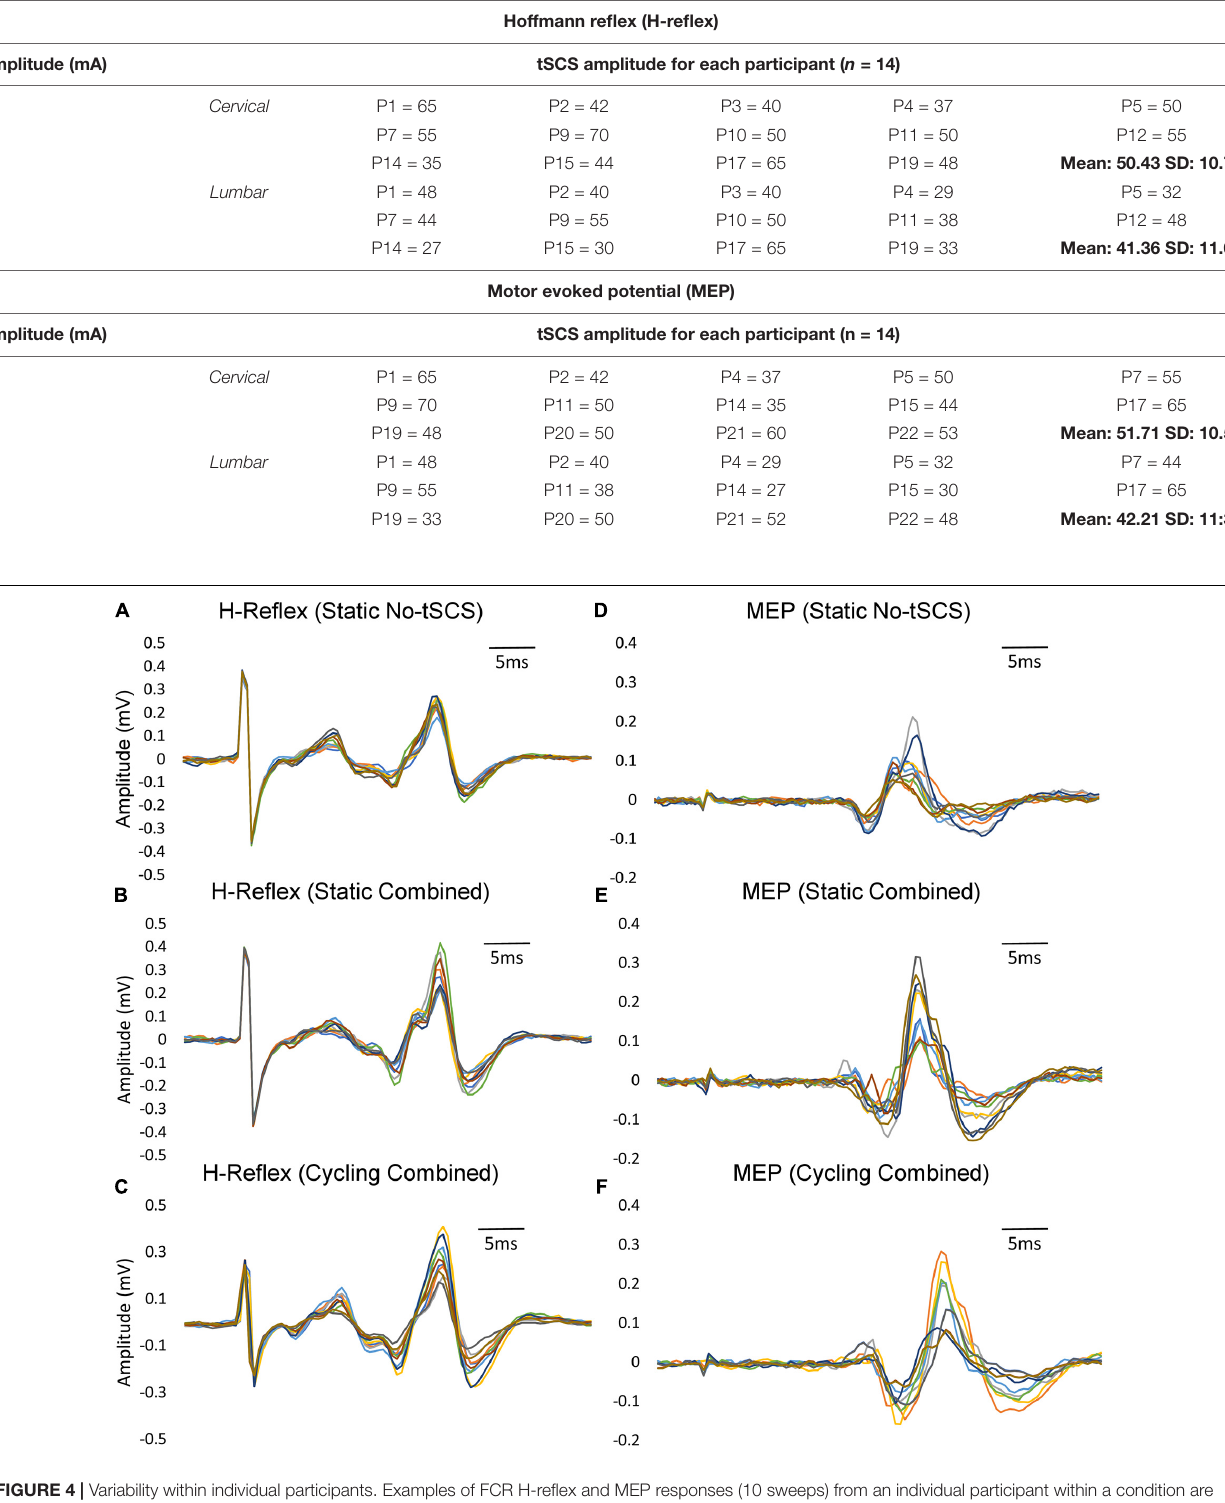
Frontiers in Neuroscience |